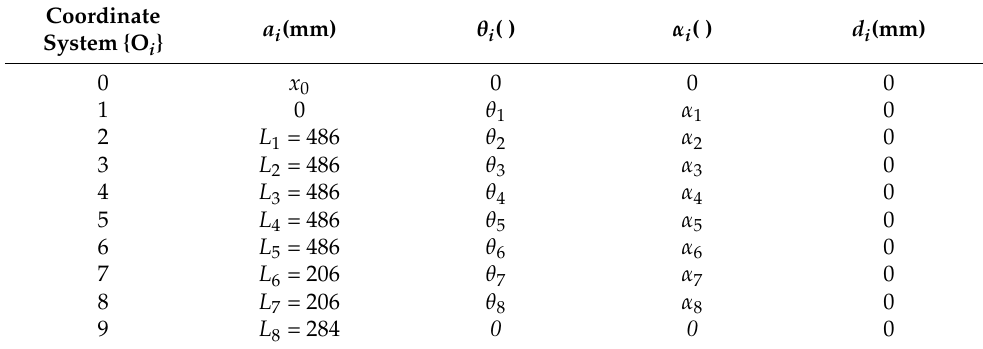
Table 1. D-H parameters of the HRM.